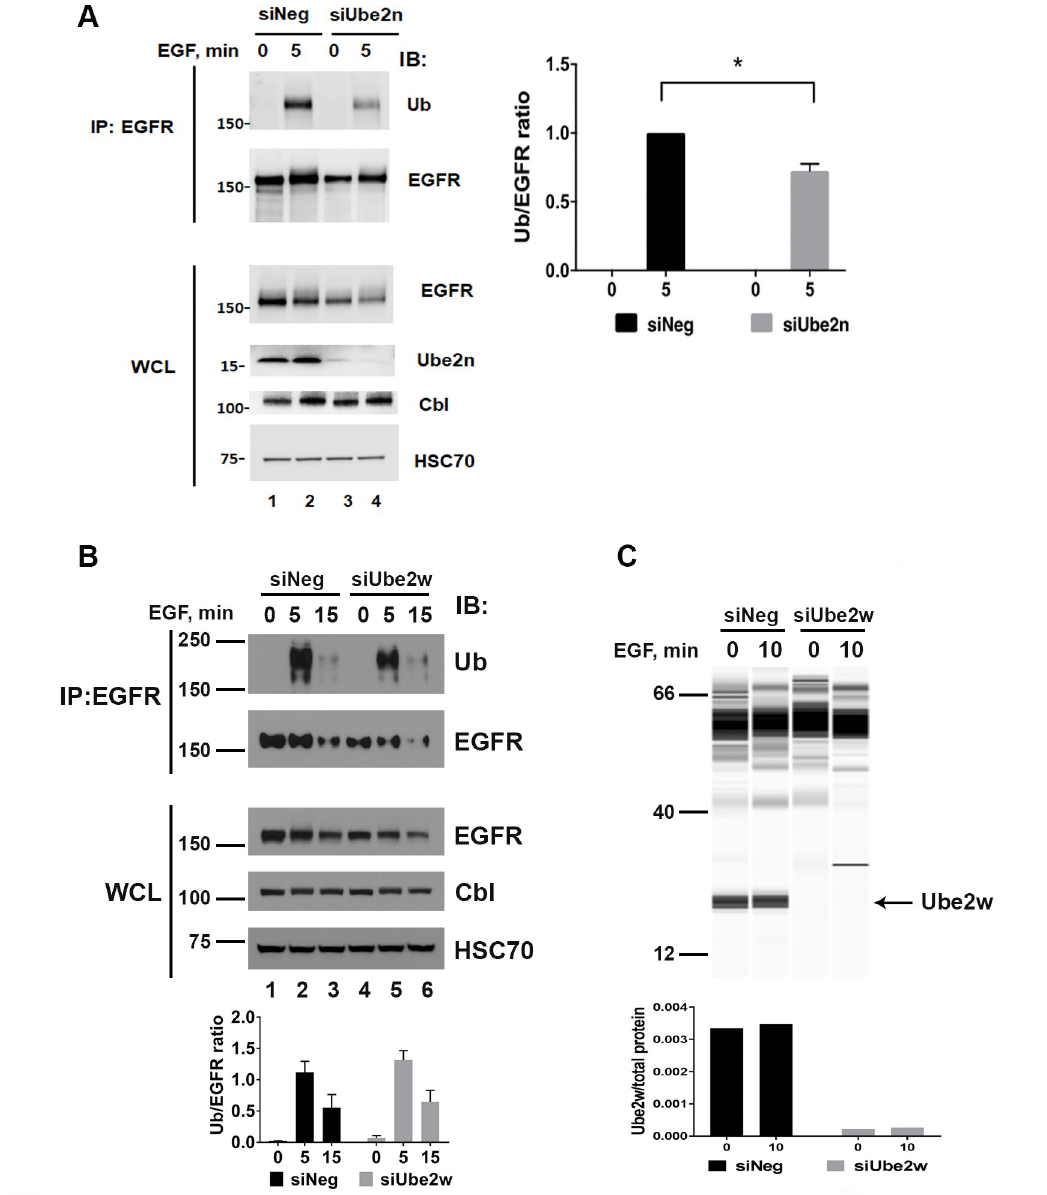
Fig 8. Ube2N but not Ube2w modulates Cbl-mediated ubiquitination of the EGFR in cells. (A) Knockdown of Ube2n in HeLa cells reduces EGFR ubiquitination. HeLa cells were transfected with control siRNA (siNeg) or siRNA targeting Ube22n for 72 hours and then treated with EGF (25 ng/mL) for 5 min. Whole cell lysates (WCL) were subjected to western blot analysis using antibodies to detect Ube2n, EGFR, Cbl and HSC70 as indicated. EGFR was immunoprecipitated from the lysates and blotted for ubiquitin (Ub) or EGFR as indicated. The graph under the WB panels shows an average ratio of Ub/EGFR ± SEM calculated by densitometry analysis of EGFR IP and normalized to the siNeg for each experiment for three independent experiments. EGFR ubiquitination in siUbe2n transfected cells was statistically lower ( � p < 0.05) than in siNeg transfected cells after 5 min of EGF stimulation. (B) Knockdown of Ube2w in HeLa cells did not affect EGFR ubiquitination. HeLa cells were transfected with control siRNA (siNeg) or siRNA targeting Ube2w for 48 hours and then treated with EGF (25 ng/mL) for the indicated time periods. Whole cell lysates (WCL) were subjected to western blot analysis using antibodies to detect EGFR, Cbl and HSC70 as indicated. EGFR was immunoprecipitated from the lysates and blotted for ubiquitin (Ub) or EGFR as indicated. The graph under the WB panels shows an average ratio of Ub/EGFR ± SEM calculated by densitometry analysis of EGFR IP for four independent experiments. EGFR ubiquitination in siUbe2w transfected cells was not statistically different from siNeg transfected cells after 5 or 15 min of EGF stimulation. (C) Ube2w knockdown was confirmed by detection of the protein using Simple Western capillary electrophoresis assay. The upper panel shows Ube2w protein levels on a simulated immunoblot of HeLa cells transfected as in